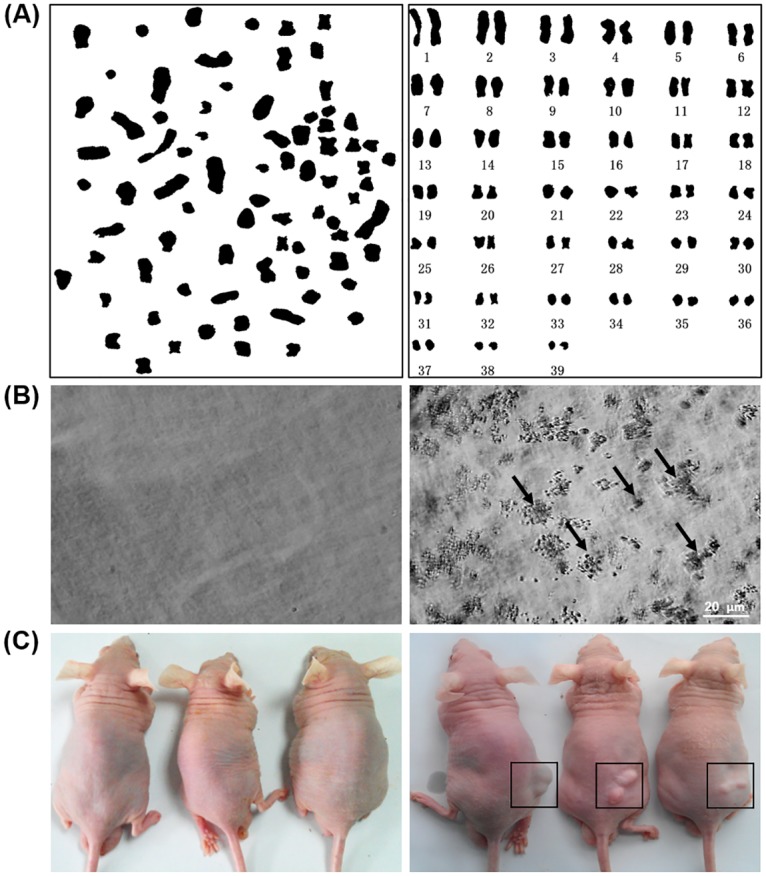
Chromosomal analysis and tumorigenicity study of the GEE cell line.(A) For chromosomal analysis, representative metaphase spread and karyotype of the GEE cell line showed 39 pairs of chromosomes specific to goose (2n = 78). For tumorigenicity study, (B) soft agar assay was used to analyze transformation properties of the GEE cell line in vitro. Inverted microscope (OLYMPUS CKX41) was used to image colonies formation either in GEE cell line (left panel) or in SP2/0 cell line (right panel). Colonies formation in the SP2/0 cell line referred with arrows. (C) The balb/c nude mice were inoculated SQ with either GEE (left panel) or SP2/0 cell line (right panel) for in vivo study. Tumor formation in the injected mice with SP2/0 indicated with squares.